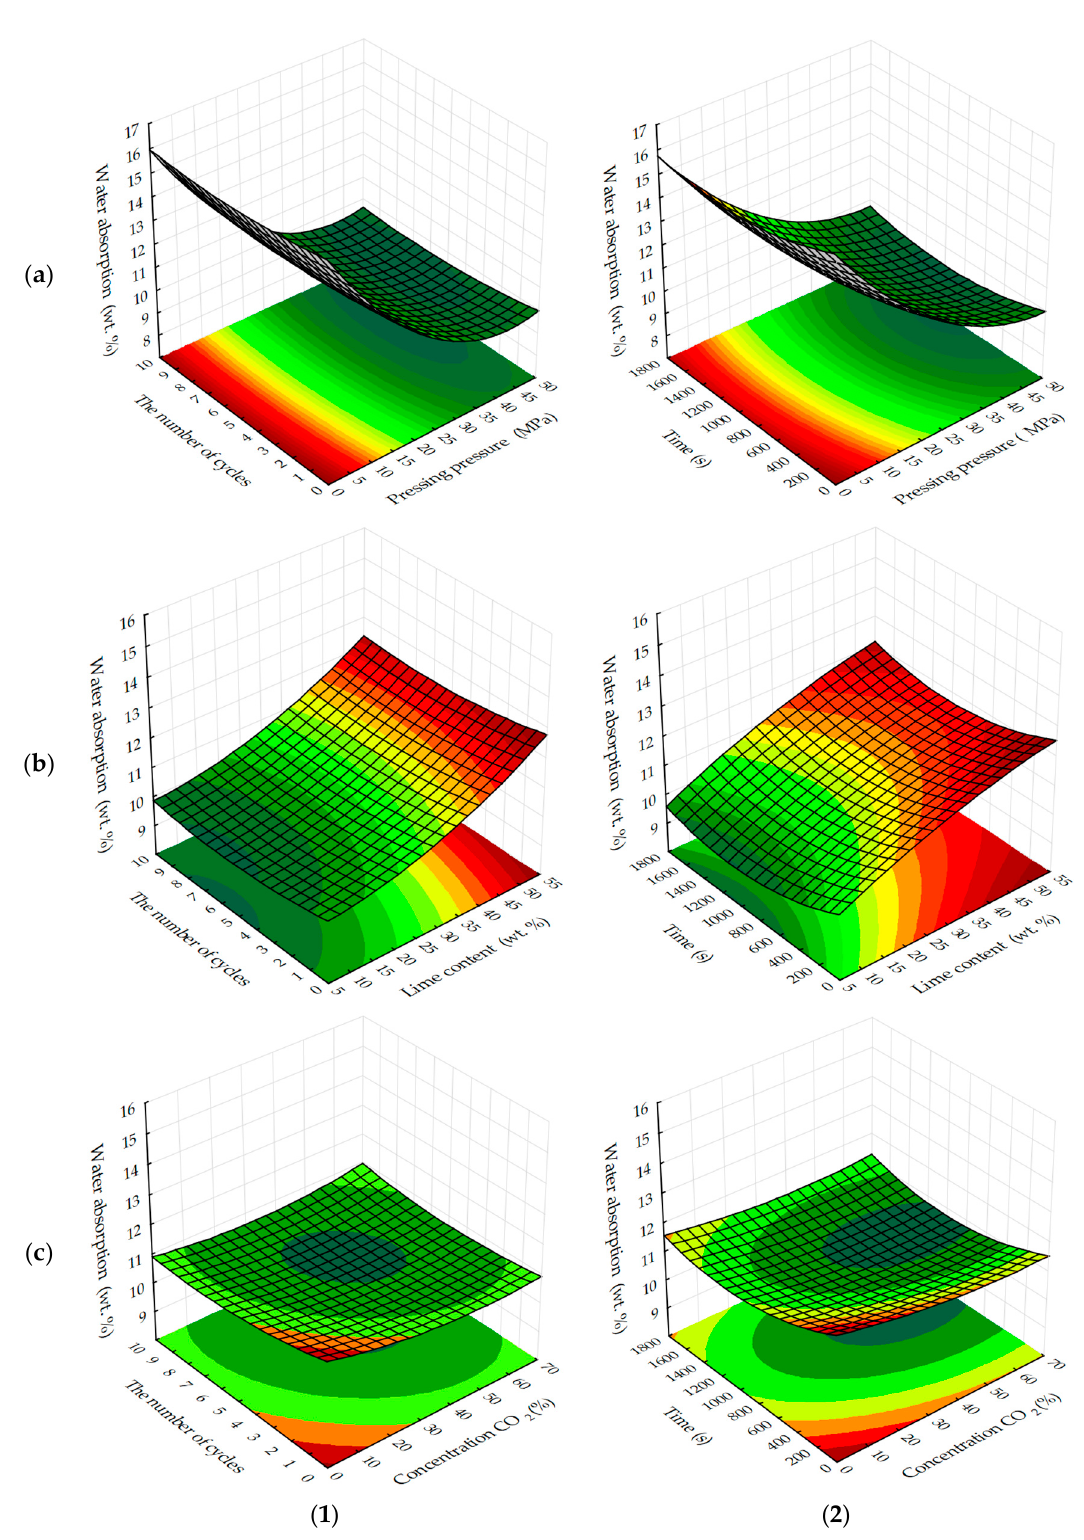
Figure 10. Response surfaces to changes in water absorption by mass of testing samples carbonated by dynamic ( 1 ) and static ( 2 ) methods, depending on the number of cycles/carbonation time and: ( a ) pressing pressure; ( b ) lime dust content; ( c ) CO 2 concentration (at zero level of variation of other factors).